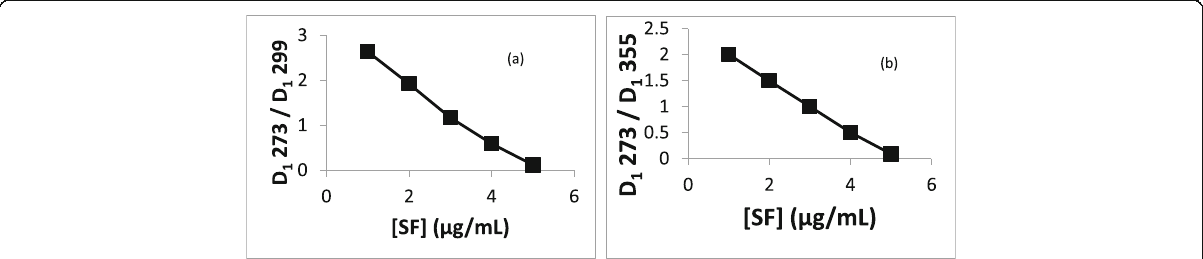
Fig. 3 Graphical plot of the ( a ) (D 1 273/D 1 299) and ( b ) D 1 273/D 1 355 ratio of VP-SF mixture in the sample cell versus SF in the reference cell for the determination of